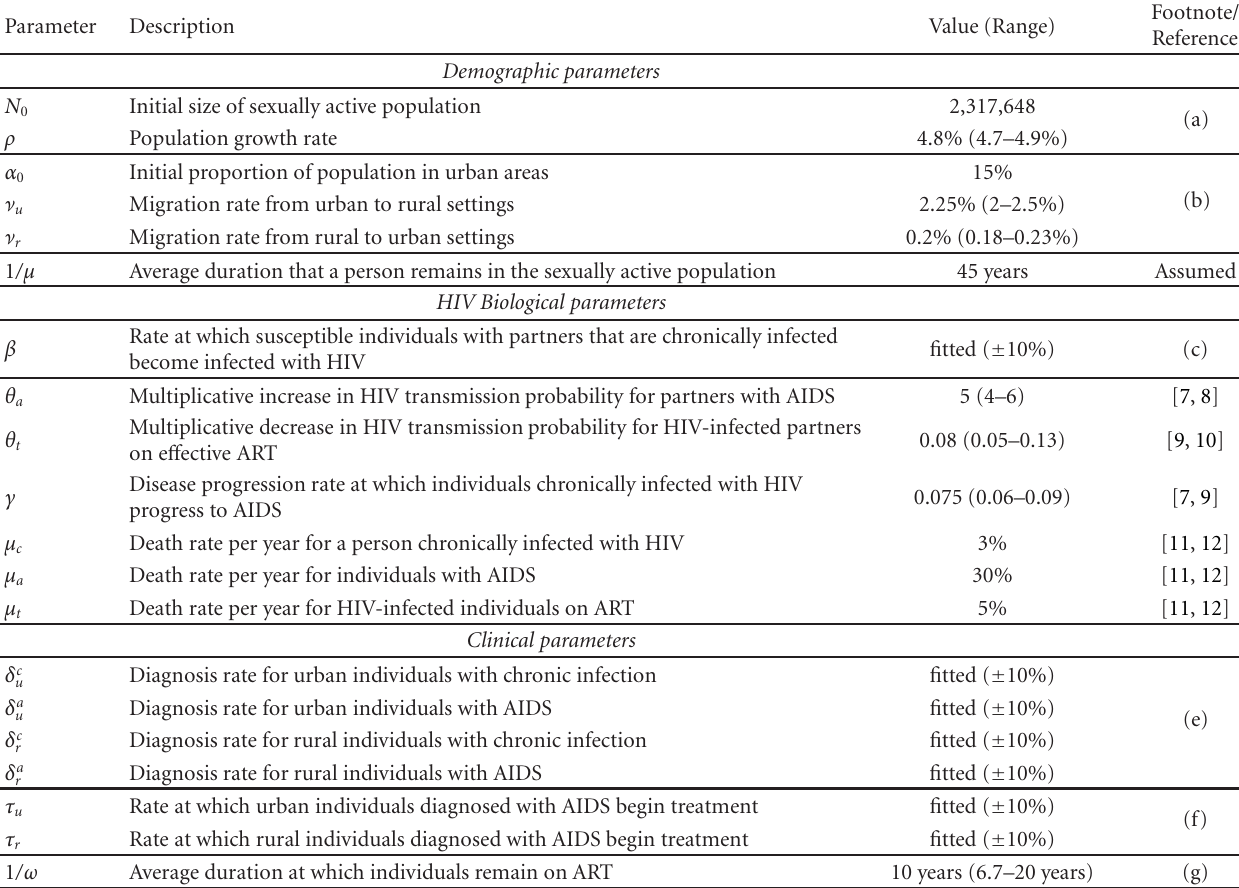
Table 1: Definitions and value ranges for input and fitting parameters used in our HIV transmission